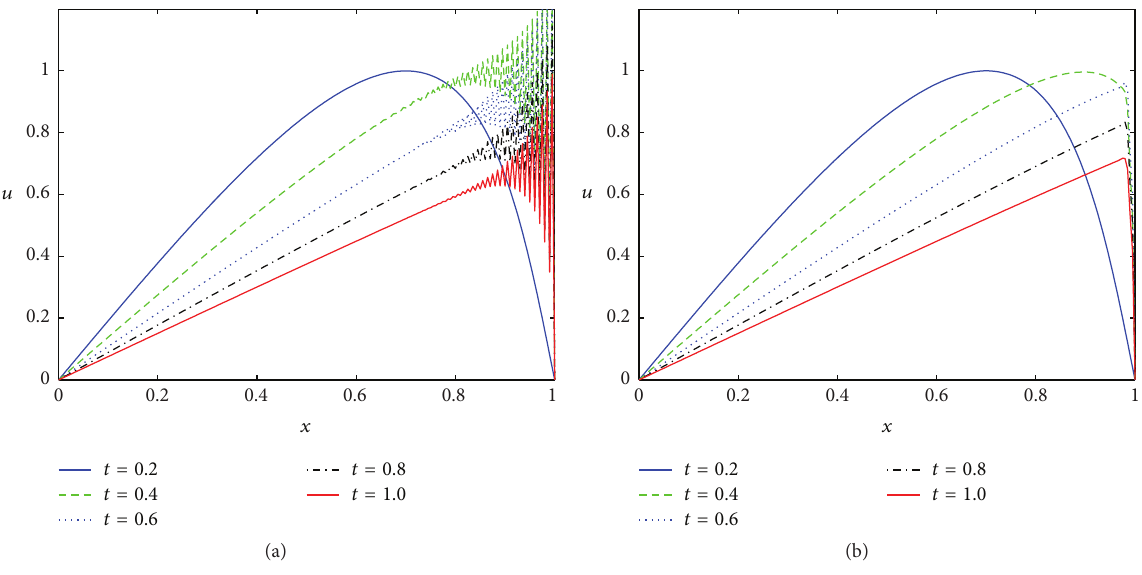
Figure 8: Effects of filtering for solving one-dimensional Burgers’ equation for Re = 10 9 by the VMEFG method. (a) is obtained without filter and (b) is with low-pass